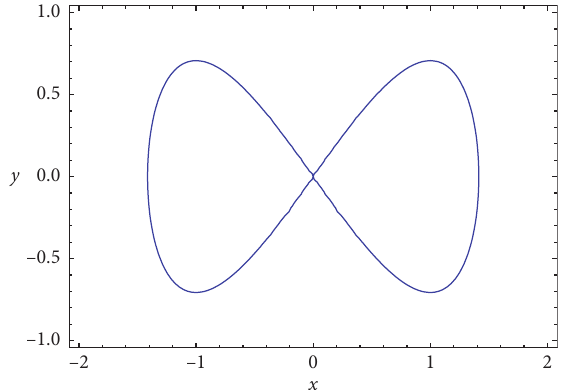
Figure 2: The phase portraits of Hamiltonian